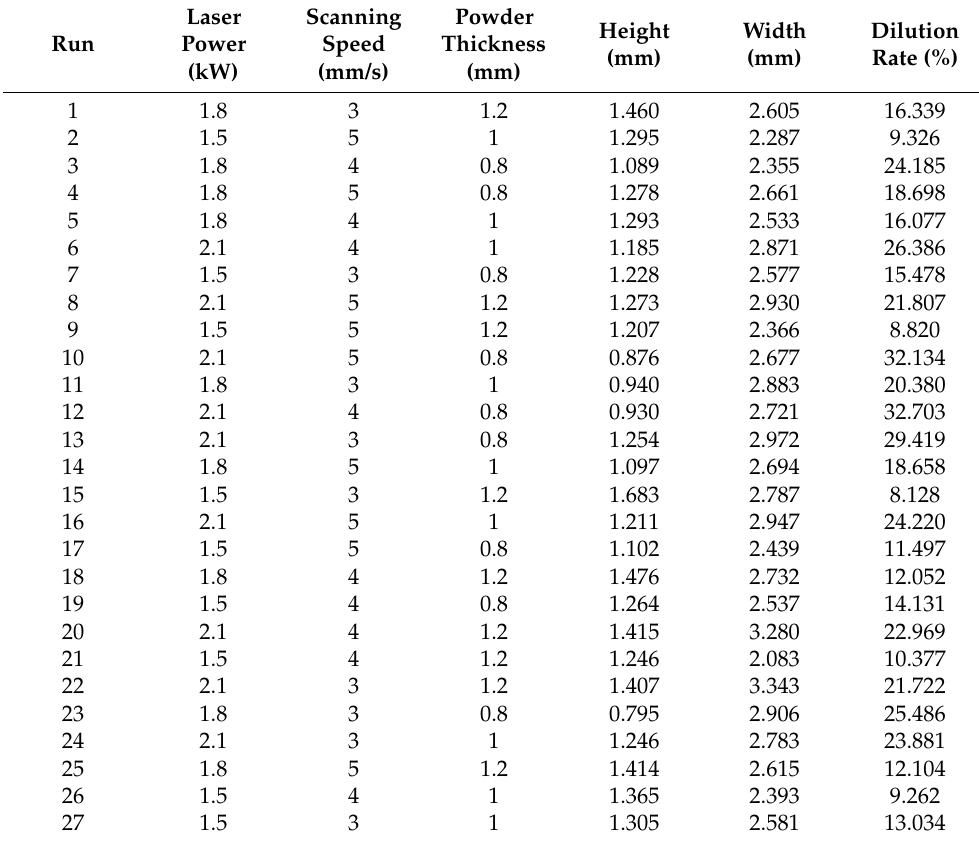
Figure 4. ( a ) Schematic illustration of cross-sectional measurements of the clad; ( b ) cross-sectional morphology of Mo 2 FeB 2 coating. Table 5. Geometric characteristics measured from obtained samples.